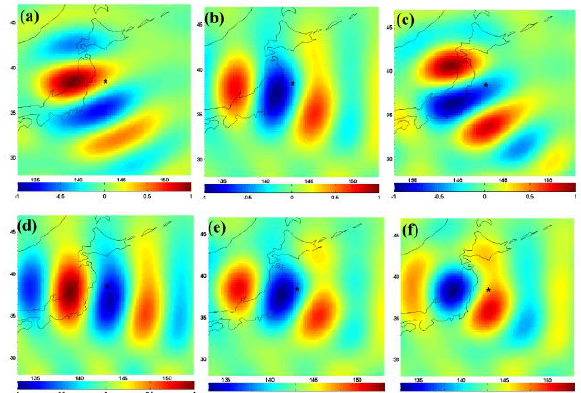
Figure 3. Gravitational gradient changes from GRACE data component a) ΔV xx , b) ΔV xy , c) ΔV xz , d) ΔV yy , e) ΔV yz , and